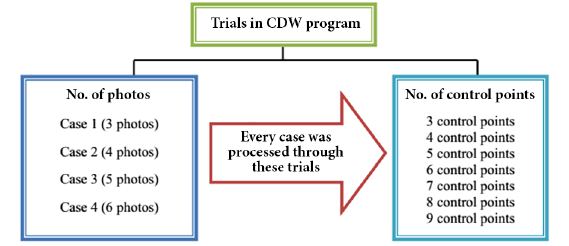
Figure 7. Flow chart of studied trials using CDW